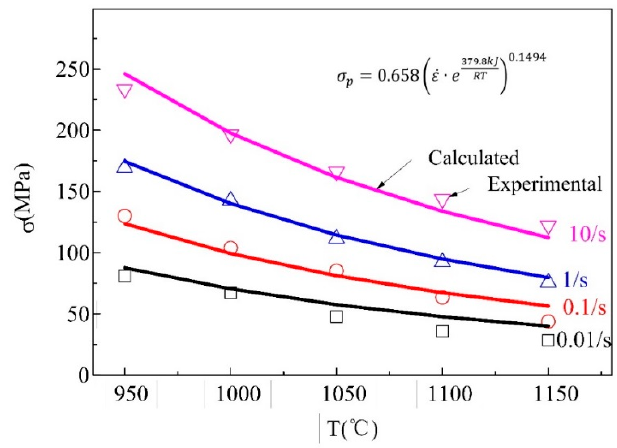
Figure 5. Fitting of peak stress to obtain the activation energy.